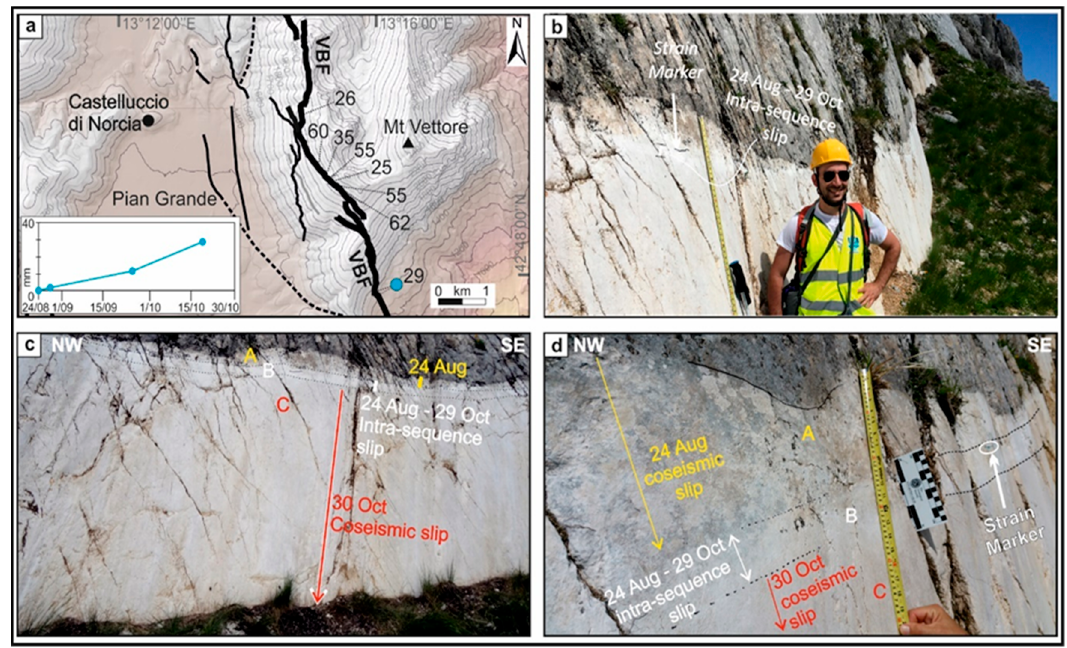
Figure 2. Field evidence of intra-sequence slip deformations along the Mt Vettore-Mt Vettoretto segment of the Mt Vettore-Mt Bove Fault (VBF), from 24 August to 29 October 2016. This fault segment was not reactivated during the Mw 5.9, 26 October event. ( a ) Location of survey sites where the total displacement due to Intra-sequence Ground Deformation (IGD, in mm) was measured on composite free faces. The inset shows the temporal trend of deformation where the VBF crosses Forca di Presta Provincial road SP34 (site #29). ( b ) Panoramic view of the free face exhumed along the VBF fault scarp (sites from #35 to #60). ( c , d ) Details of composite free faces documenting the 24 August-30 October slip-history along the VBF: (A) Upper band showing the coseismic slip caused by the 24 August Mw 6.0 foreshock; (B) Intermediate band showing the intra-sequence slip, between 24 August and 29 October 2016; (C) Lower (and thicker) band showing the coseismic deformation caused by the Mw 6.5